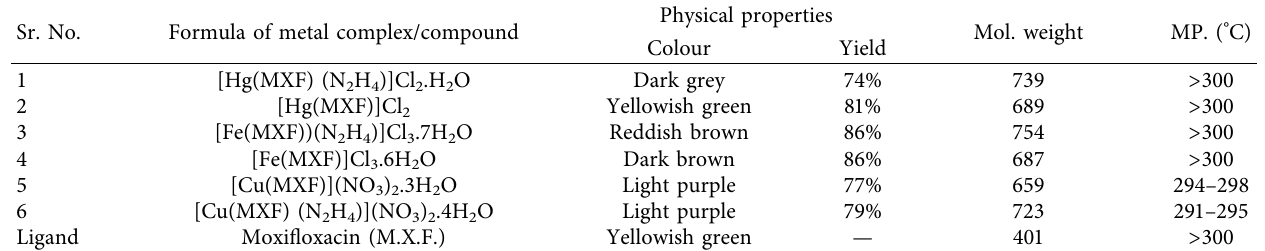
Table 1: Physical data of moxifoxacin and synthesised metal